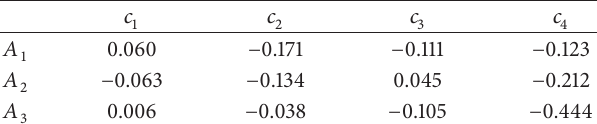
Table 5: Prospect value matrix 𝑃 = (𝑧 𝑖𝑗 ) 𝑚×𝑛